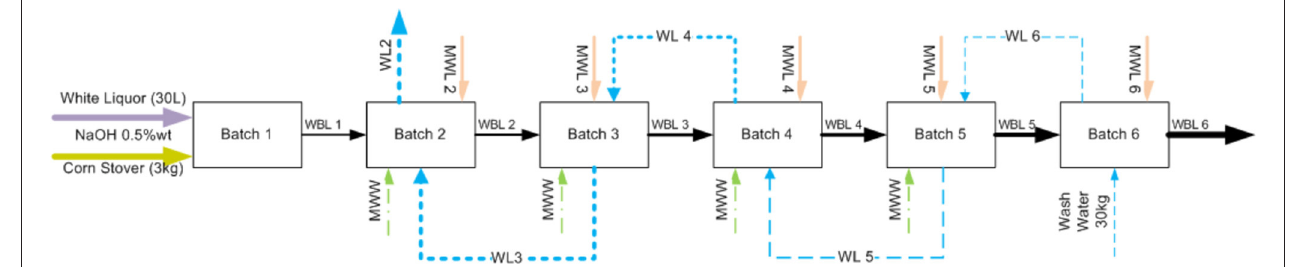
FIGURE 2 | Schematic diagram of proposed weak black liquor recycling. WBL, weak black liquor; MWW, makeup wash water; MWL, makeup white liquor; WL, wash liquor.